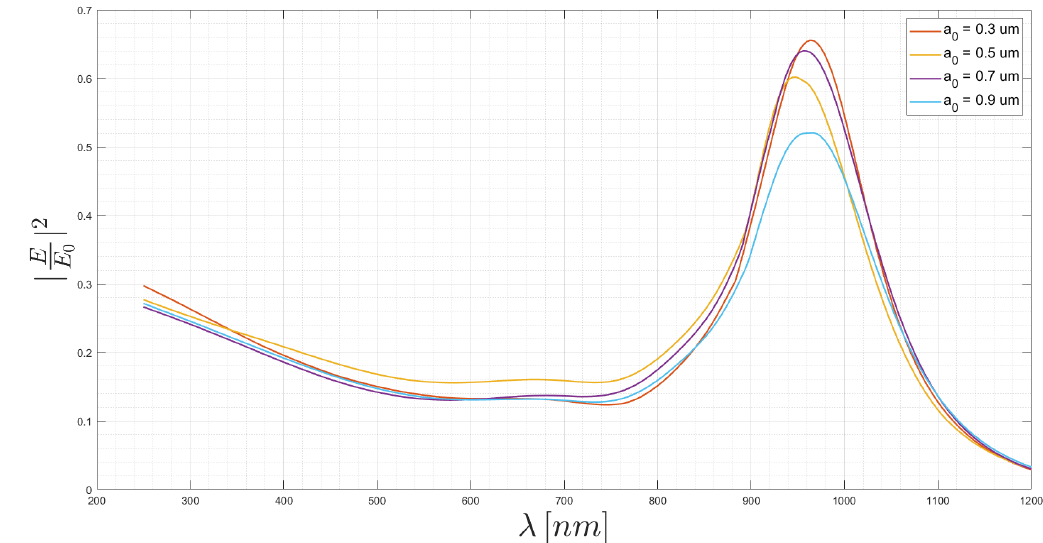
Figure 3. Periodicity sweep on a gold nanostructure with a quartz substrate.